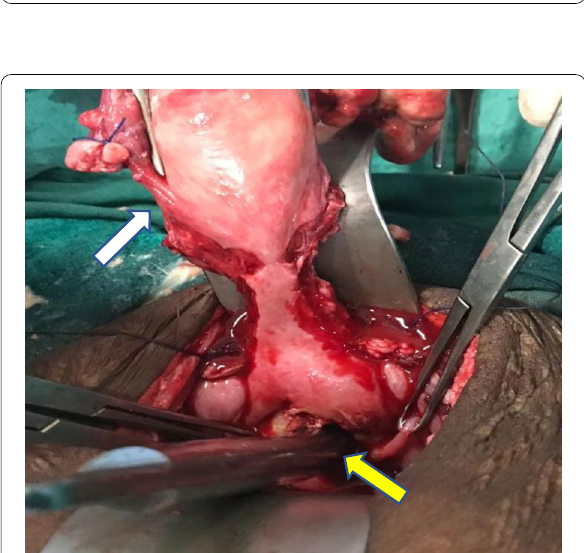
3 cm (yellow arrow) ×